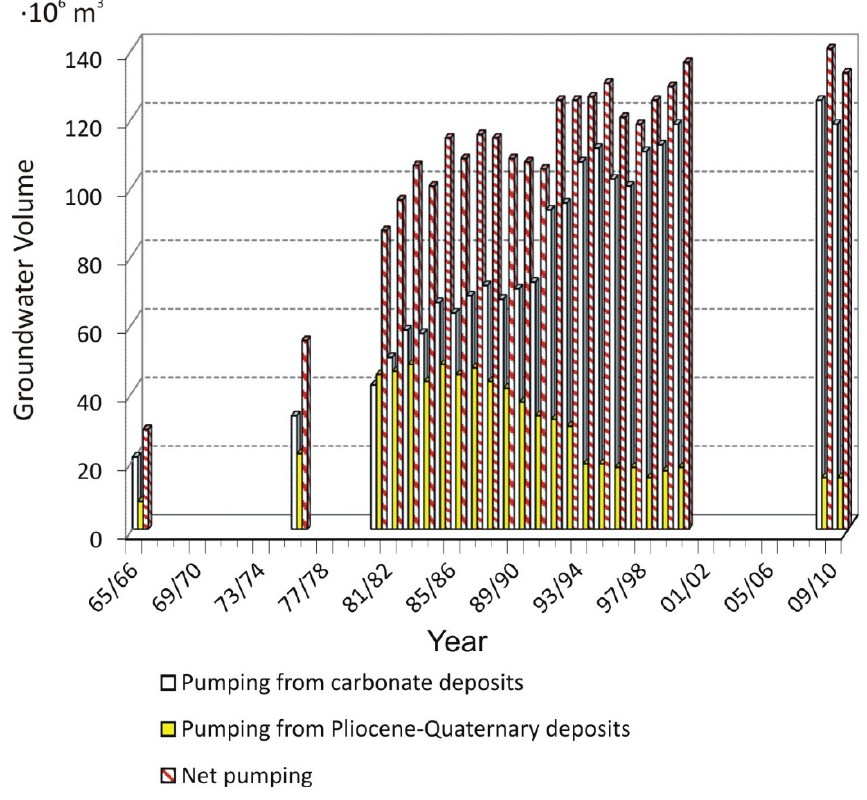
Figure 5. Evolution of groundwater exploitation (m 3 ) in carbonate and detritic aquifers from 1965 to 2010 (in blank: there is no data).